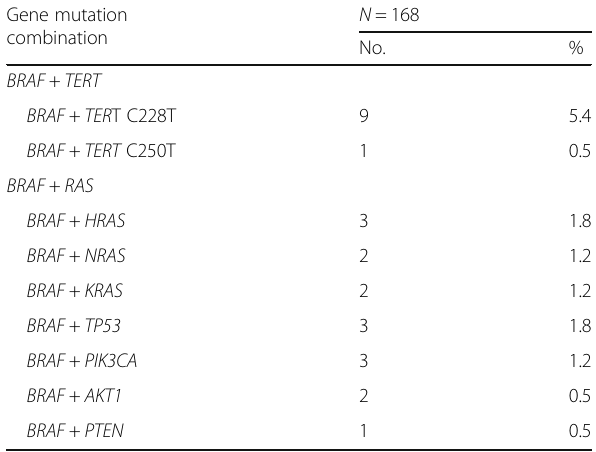
Table 3 Coexistence gene mutation of PTC Gene mutation combination